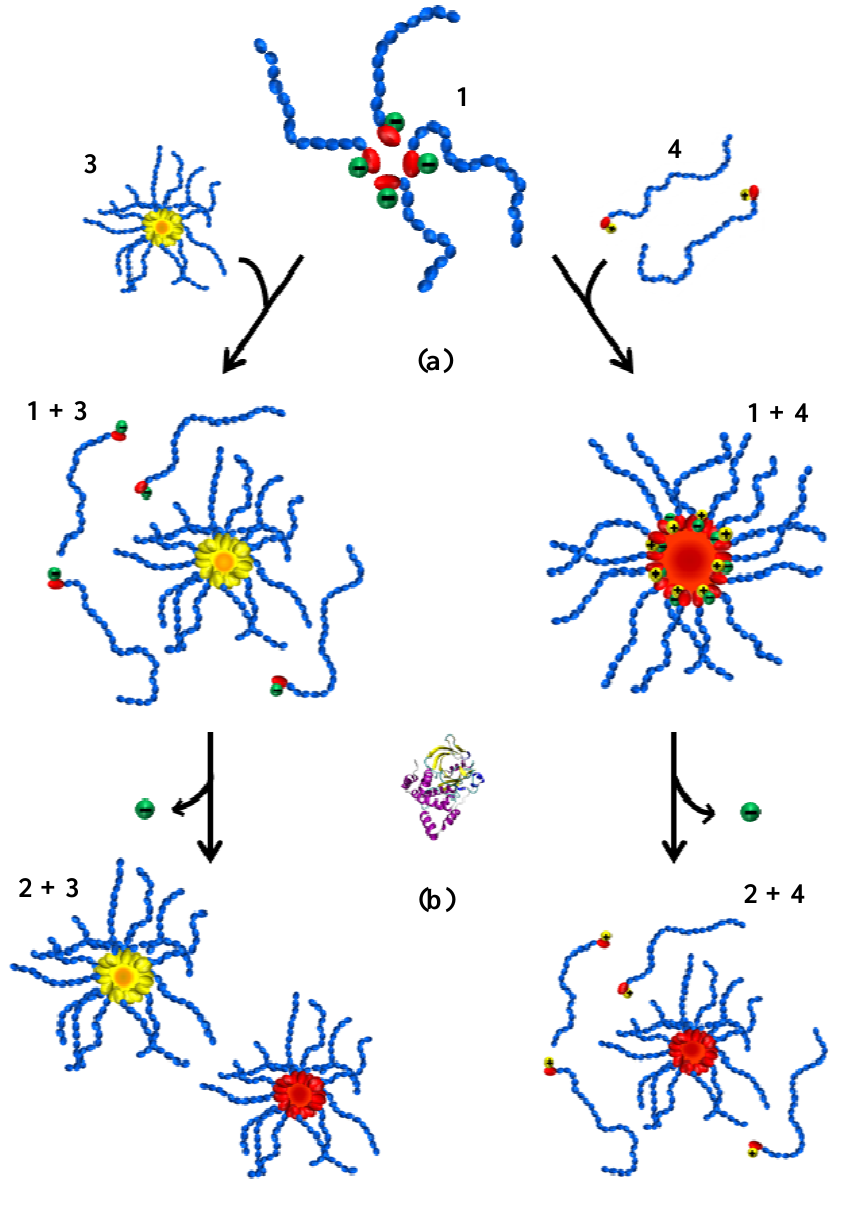
Figure 5. Schematic representation of self-assembly behaviour of dual component systems. ( a ) When 1 and 3 are mixed, only 3 undergoes self assembly, while, when 1 and 4 are mixed, both polymers self-assemble due to the contribution given by the opposite charges present on the amino acids; ( b ) Upon enzymatic dephosphorylation of the tyrosine, 2 and 3 form distinct colloidal aggregates despite their chemical similarity, while 4 is expelled from the nanostructures which are now formed only by 2